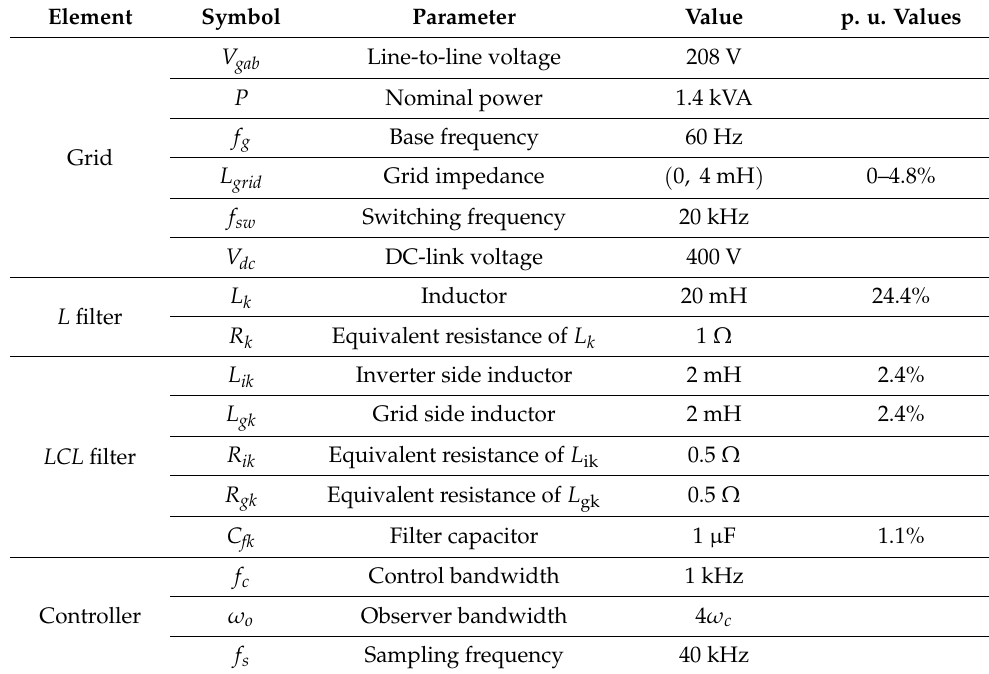
Table 1. System parameters.